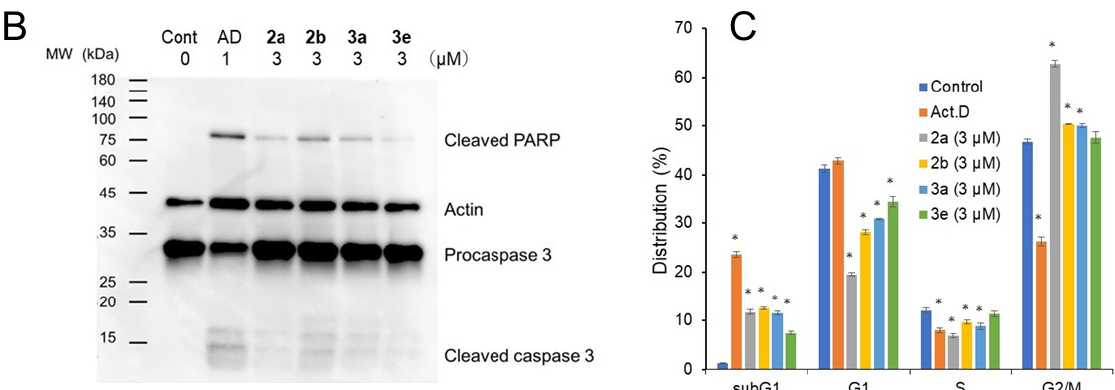
Figure 5. Induction of cell shrinkage ( A ), caspase 3 activation ( B ), and subG1 and G2/M accumulation by 2a , 2b , 3a , and 3e . Ca9-22 cells were treated for 24 h with vehicle (control), actinomycin D (Act.D) (1 µM), 2a , 2b , 3a , and 3e (3 µM) in Ca9-22 cells. Each value is represented as the mean ± S.D. of triplicate determinations. * p < 0.05 vs. control (Bonferroni’s post-test) ( C ).